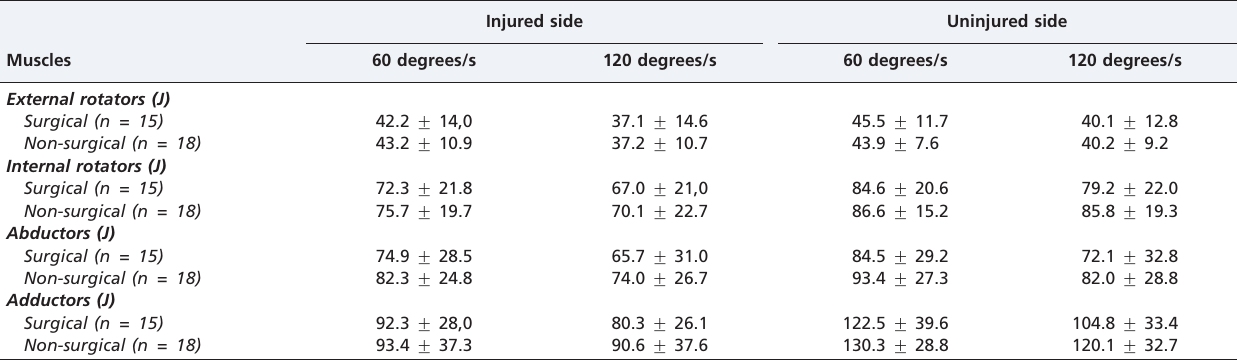
Table 2 - Total work for the internal and external rotator muscles and the horizontal abductor and adductor muscles of the shoulder at angular speeds of 60 and 120 degrees/s in athletes who had undergone surgical and non-surgical treatments.